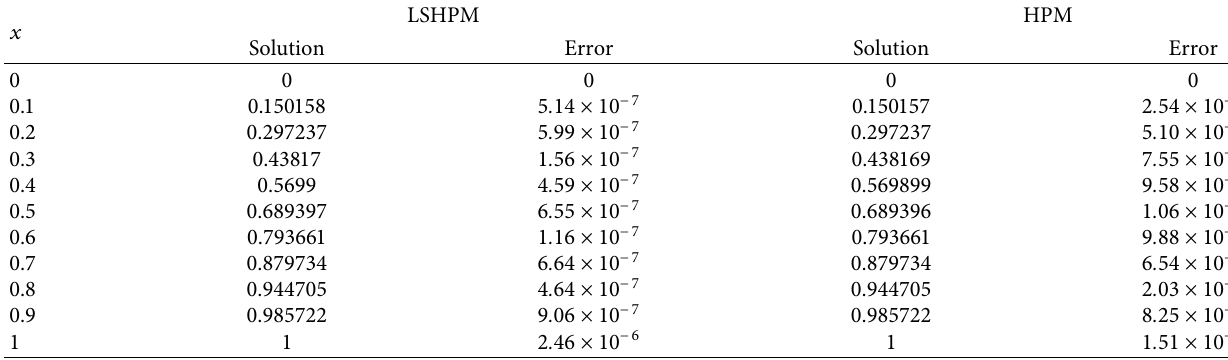
Table 6: Comparison of second-order absolute error of LSHPM with HPM in Problem 6.